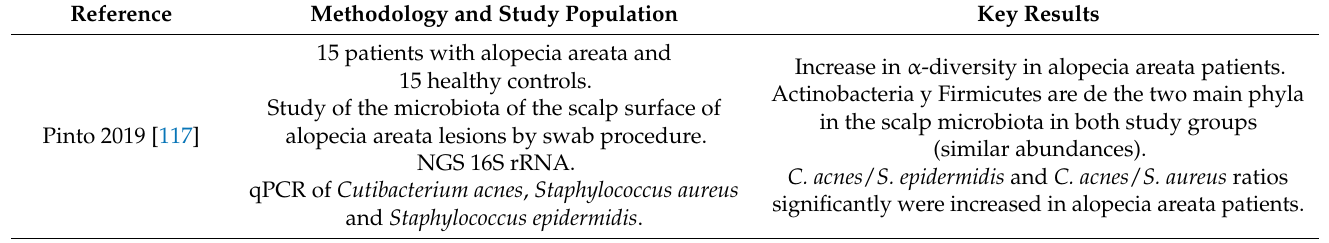
Table 1. Main studies scalp microbiota-related in patients with alopecia areata. NGS: Next